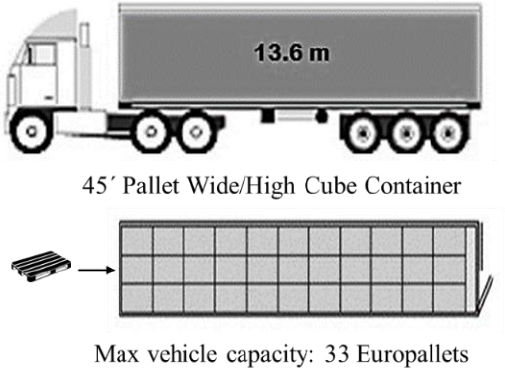
Fig. 4. Model vehicle of the analysis.